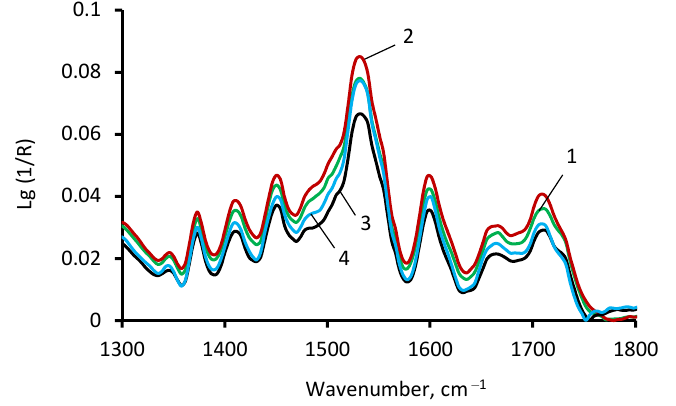
Figure 7. FTIR spectra of polymers modified with ASiP–AGM-10 at its content of 0 (1), 0.05 (2), 0.1 (3) and 0.2 (4) wt%.